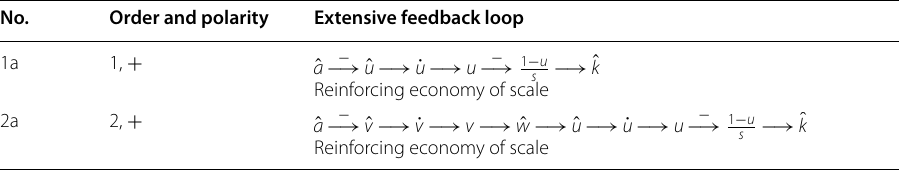
Table 5 Extensive feedback loops of growth rate of output per worker ˆ a in initial B-1